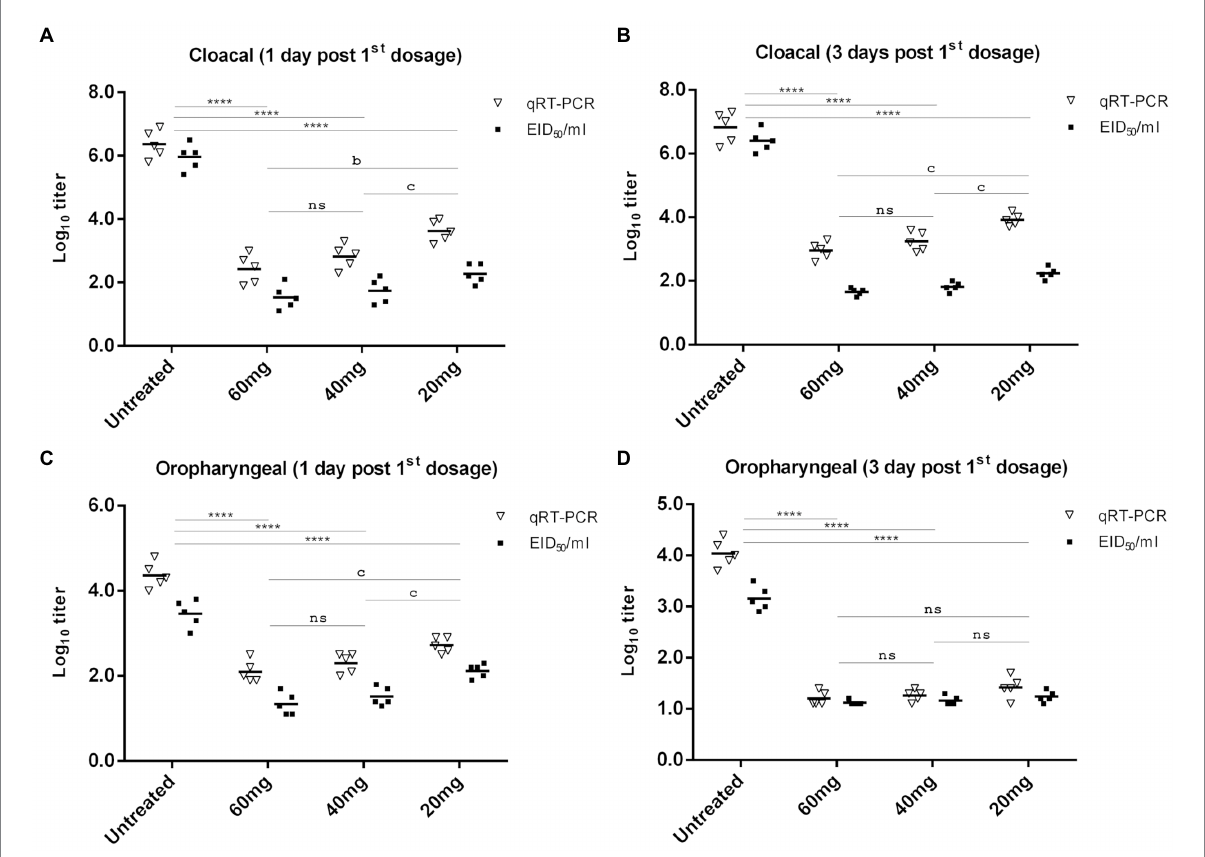
FIGURE 6 NDV cloacal (A,B) and oropharyngeal (C,D) shedding in experimentally infected (10 6 EID 50 ) chickens one and 3 days after treatment with 20, 40, and 60 mg/k.g BW n -docosanol. The titer of recovered NDV was determined by qRT-PCR and the infectivity assay using ECE. The asterisk indicates a significant difference in the viral log10 value between the untreated group and the high or medium or low dosage group at the same time point ( p < 0.01) and error bars included. ns represents the non-significant